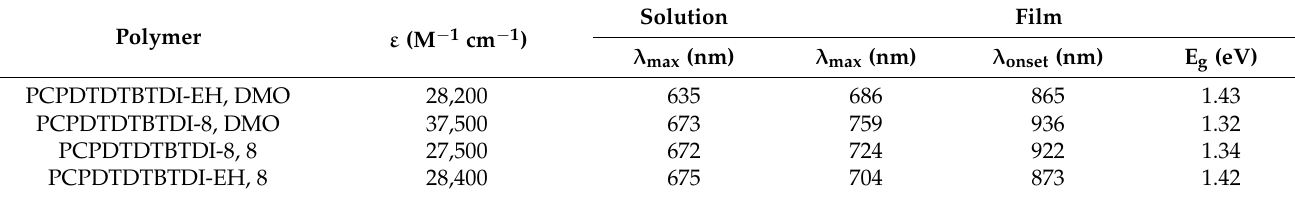
Table 2. The UV–VIS data and optical band gaps of the